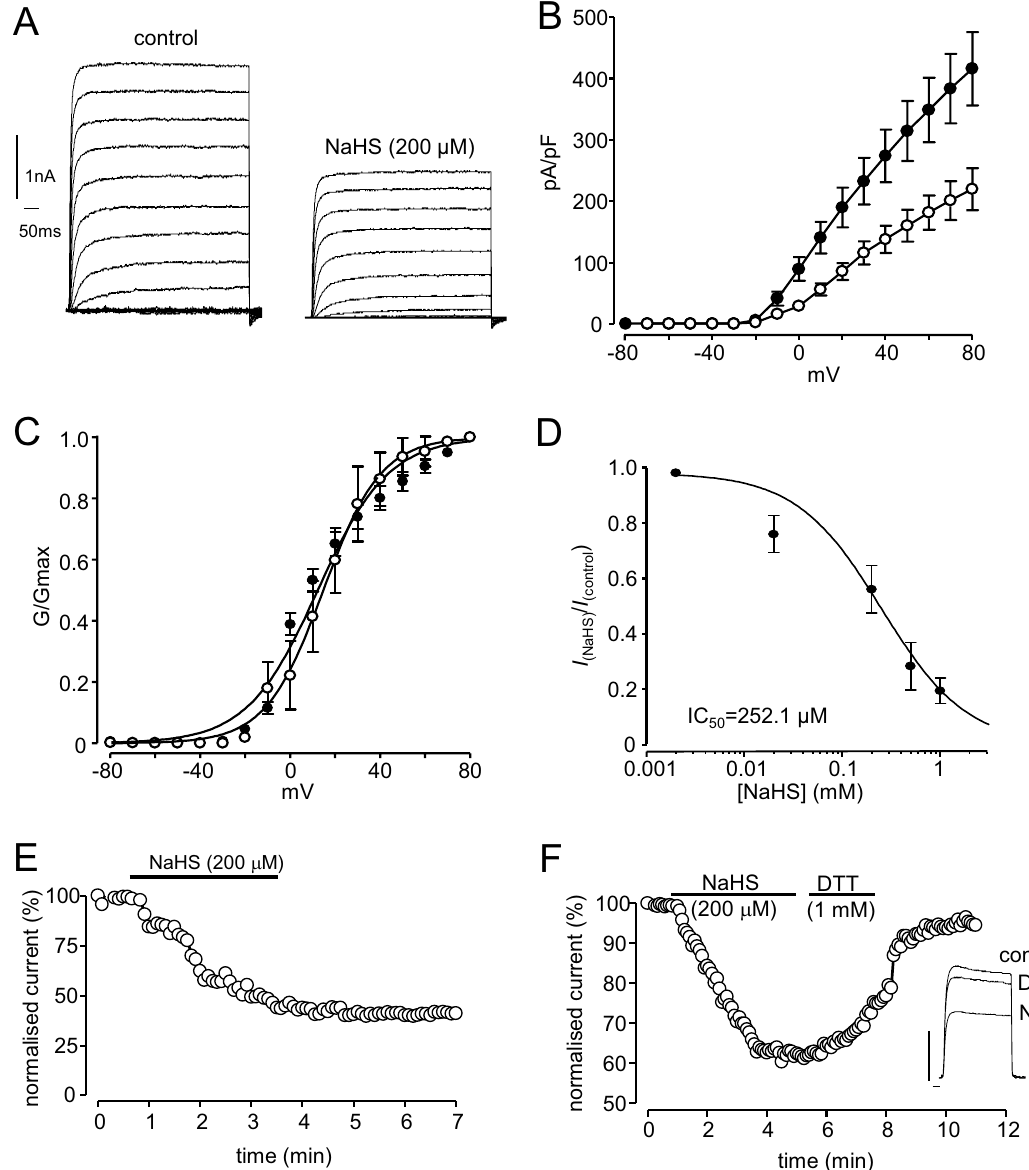
Figure 1. NaHS inhibits recombinant Kv2.1. ( A ) Families of currents evoked in a HEK293 cell stably expressing Kv2.1 before and during exposure to NaHS (200 μM). Currents were evoked by step-depolarizations, applied up to + 80 mV in 10 mV increments from a holding potential of − 70 mV. Scale bars apply to both families of currents. ( B ) Mean (± s.e.m.) current–density versus voltage relationships obtained in 17 cells before (solid circles) and during (open circles) exposure to NaHS (200 μM). ( C ) Mean (± s.e.m., each point taken from 5 to 7 cells) concentration–response relationship illustrating the effects of NaHS on Kv2.1. Inhibition was determined using currents evoked by step-depolarizations from − 70 to + 50 mV). ( D ) Plot of voltage-dependence of activation of Kv2.1 before (solid circles) and during (open circles) exposure to NaHS (200 μM). Data are means ± s.e.m. Curves were obtained by fitting data to the sigmoidal Boltzmann function. ( E ) Example time- series plot illustrating normalized current amplitudes evoked by step-depolarizations from − 70 to + 50 mV in a Kv2.1-expressing HEK293 cell. For the period indicated by the horizontal bar, NaHS (200 μM) was applied via the perfusate. ( F ) as ( E ), except that, following washout of NaHS, the cell was exposed to dithiothreitol (DTT, 1 mM) for the period indicated by the second horizontal bar. Inset shows example currents under the conditions indicated (DTT applied after washout of NaHS). Scale bars: 2 nA (vertical) and 10 ms